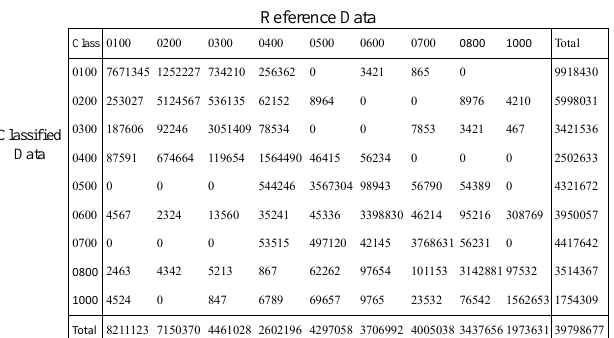
Table 2. Error matrix of number of object samples